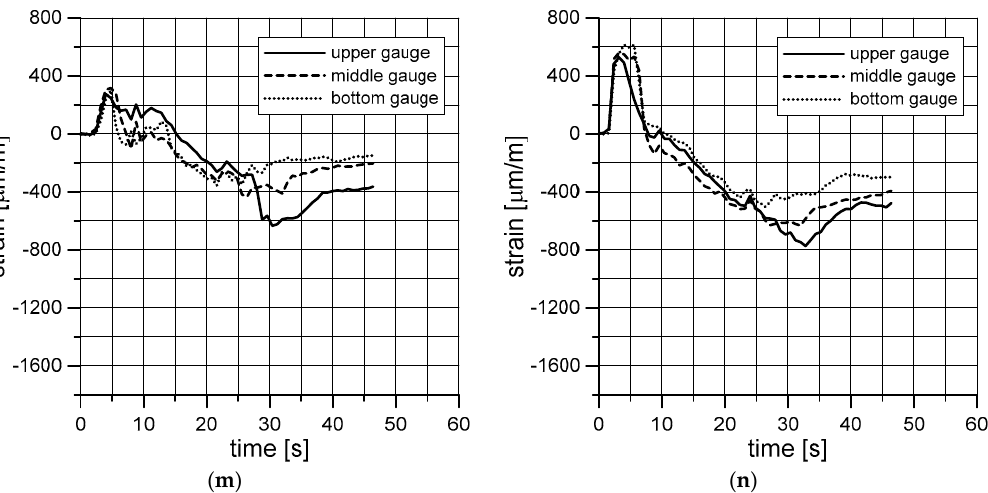
Figure 10. Averaged results obtained for different valve settings controlling the individual steam sections: ( a , b ) series 1; ( c , d ) series 2; ( e , f ) series 3; ( g , h ) series 4; ( i , j ) series 5; ( k , l ) series 6; ( m , n ) series 7.